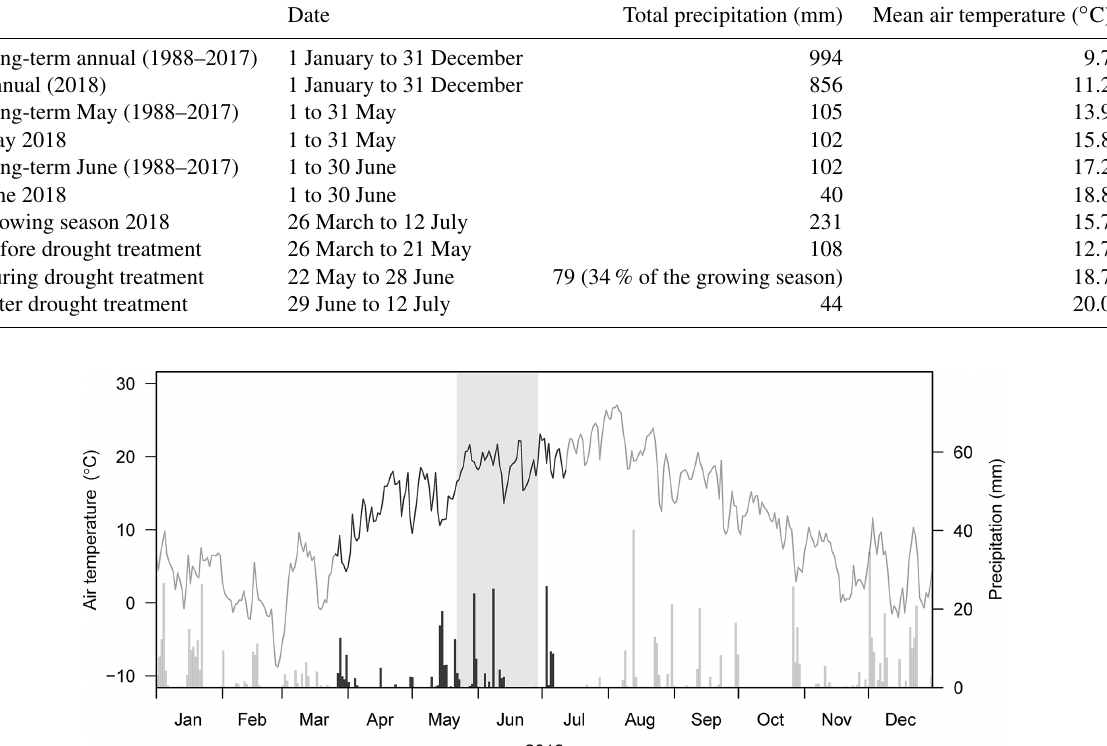
Figure 1. Daily air temperature and precipitation in 2018. Dark line segments and bars depict the crop growing season from 26 March to 12 July 2018. The shaded area indicates the drought treatment from 22 May to 28 June 2018. Data from the MeteoSwiss station Zürich/Kloten (KLO; 47.48 ◦ N, 8.54 ◦ E; 4.6km north of the research site; MeteoSwiss, 2020) are